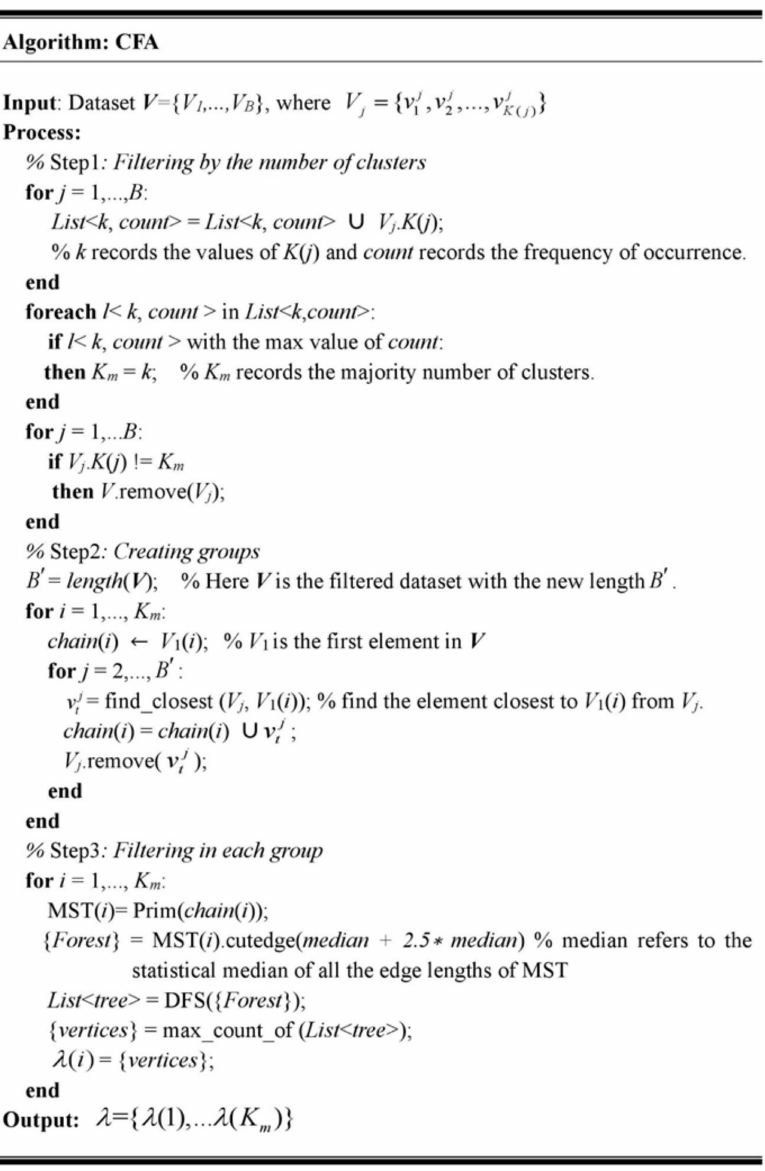
Figure 3. Pseudocode of the centroid filtering algorithm